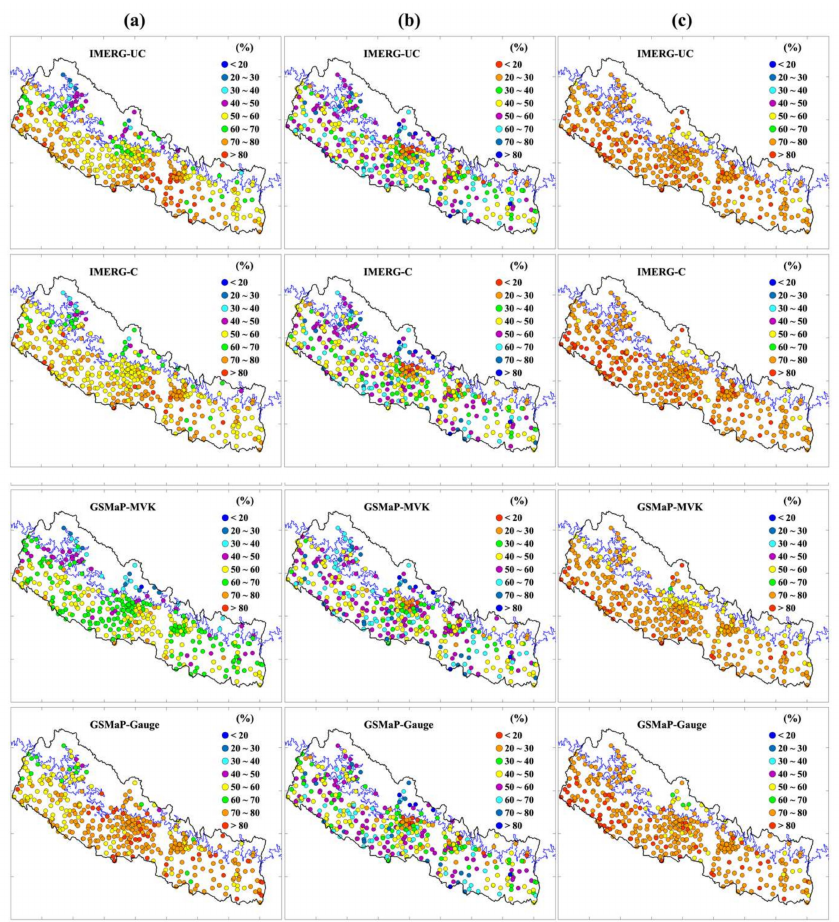
Figure 6. SBP performance at individual station measurements expressed in the form of the panel ( a ) POD, panel ( b ) FAR, and panel ( c ) ACC in % at each station during the study period. The black and blue lines show the national boundary and 3000 m elevation contour, respectively. Table 6. Performances of the four SBP datasets expressed by POD, FAR and ACC at each station, averaged over three elevation intervals ( < 1500 m, 1500–2500 m and > 2500 m), as well as for the whole study region during the study period. A threshold value of 1 mm / day was selected to separate precipitation and no-precipitation events. Bold font indicates the dataset with the best performance for a given